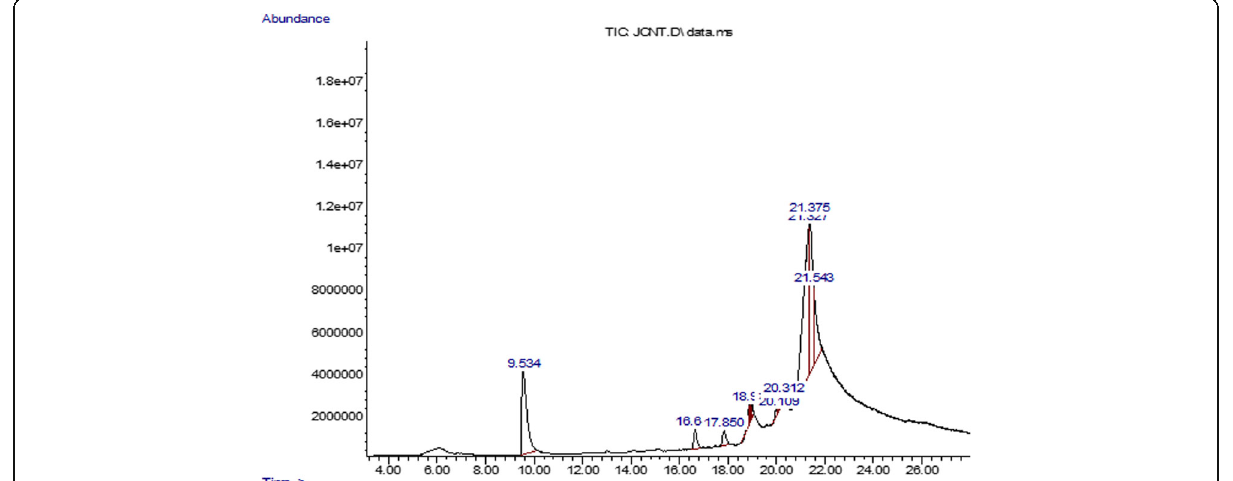
Fig. 9 Chromatogram of chemical profile of mixture of Nicotiana tabacum plus Jatropha